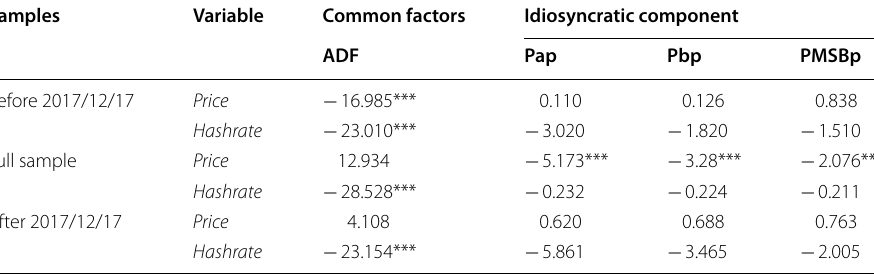
*, ** and *** show significance at the 10%, 5% and 1% levels, respectively